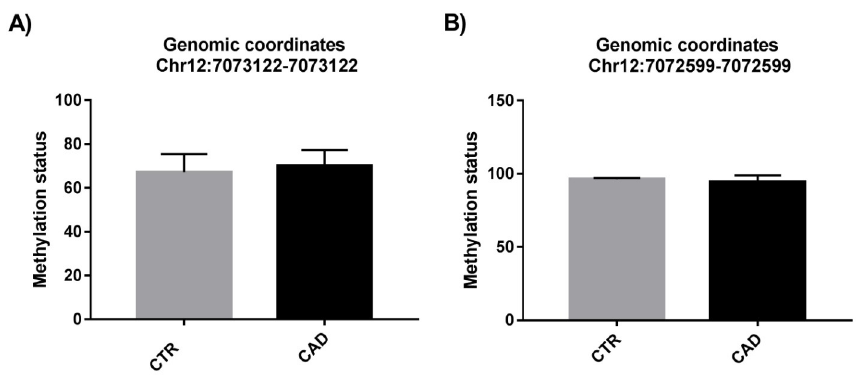
Figure 7. Methylation status of the two sites on all recruited CAD and CTR patients. ( A ) Methylation level for site chr12:7073122-7073122; ( B ) methylation level for site chr12:7072599-7072599.